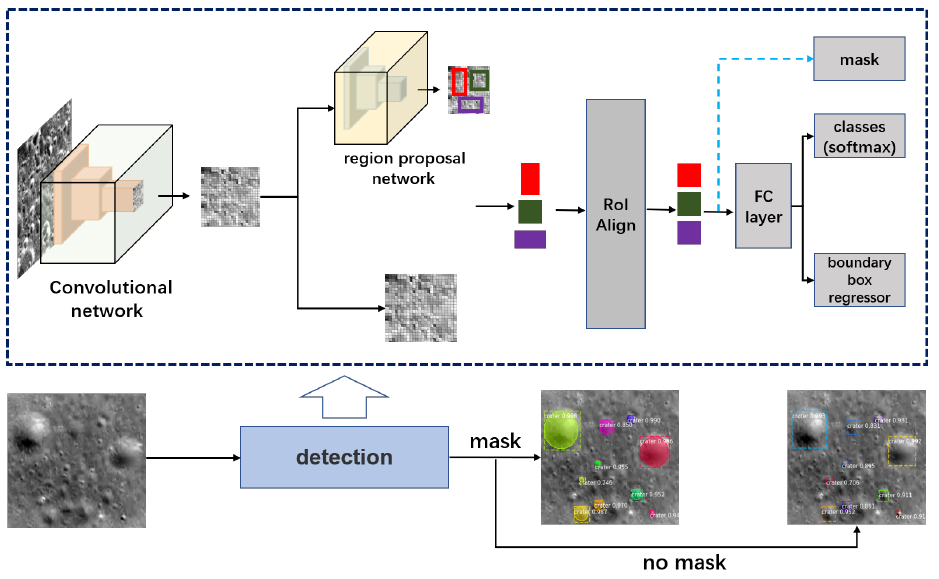
Figure 7. Mask R-CNN and no-Mask R-CNN model structure